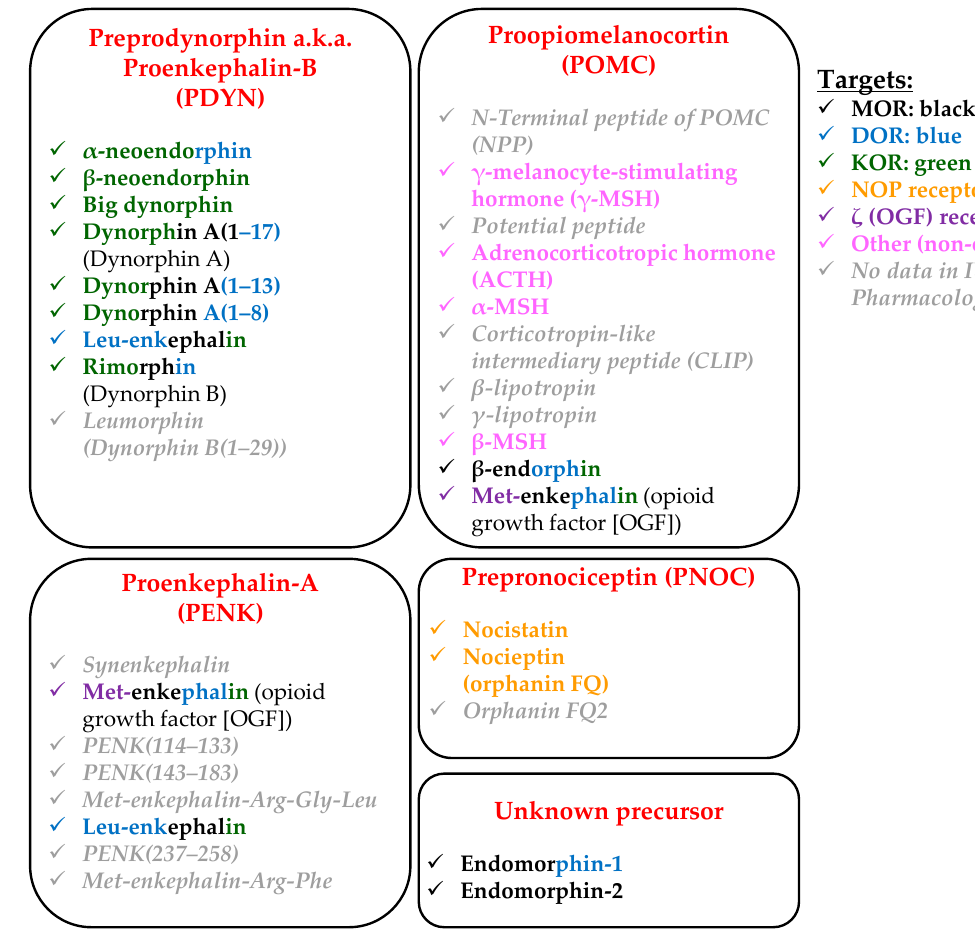
Figure 2. Overview of the origin and receptor affinity of the most important endogenous opioids. The color code indicates the relevant targets of each molecule. When one molecule can activate more than one receptor, the order of the colors from the left to the right represents the order of the affinity toward each receptor. For example, the order of colors in case of “ β -endorphin ” ( black-blue-green ) indicates that its affinity is the highest to human MOR, it is less to DOR, and even less to KOR. Affinity data are obtained from the IUPHAR Guide to Pharmacology database (accessed on 5 December 2021) and from Ref [83]. Importantly, lack of a specific color does not necessarily mean lack of the respective binding, but rather lack of experimental evidence of the said binding. Please note that we only provide affinity but not efficacy data of the substances.